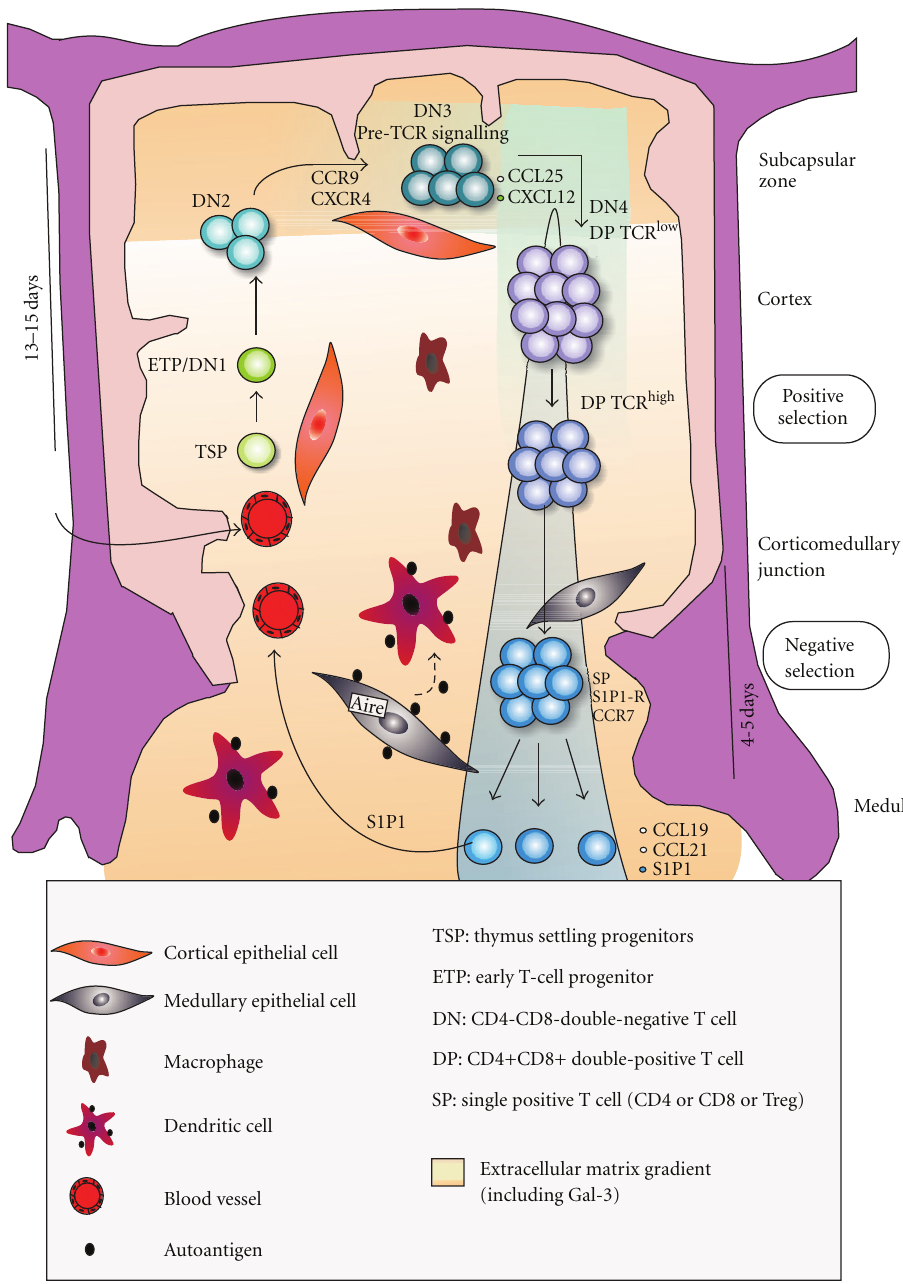
Figure 1: Intrathymic di ff erentiation of T cells . Lymphocyte di ff erentiation initiates when T-cell precursors enter the thymus through postcapillary venules located at corticomedullary junction. After entering the organ, cells interact with the thymic microenvironment (thymic epithelial cells, macrophages, dendritic cells, and fibroblasts), which ultimately lead to their proliferation and TCR rearrangement. Interactions between thymocytes and specialized thymic microenvironmental cells support and direct T cell di ff erentiation by means of a series of interactions including receptor/coreceptor interactions (MHC-TCR, Integrin/ECM Proteins), cytokines (IL-1, IL-2, IL-3, IL-6, IL-7, IL-8, IFN-gamma), chemokines (as CCL25, CXCL12, CCL21), and hormones, with corresponding receptors. At the subcapsular zone, these thymocytes undergo TCR beta chain rearrangement and selection. Double-positive thymocytes migrate through the cortex and initiate TCR testing (positive selection). Positively selected thymocytes, located at the medulla, are screened for self-reactivity through negative selection. Residence in the medulla is followed by emigration, which is regulated by sphingosine-1-phosphate and its receptor (S1P1). Adapted from